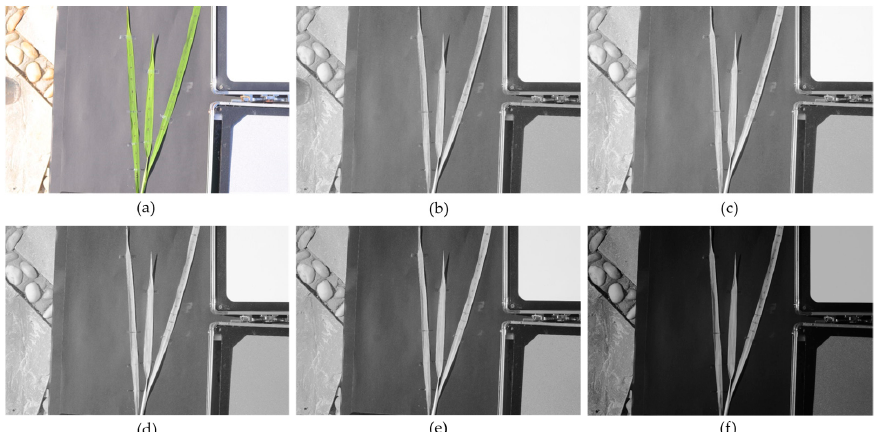
Figure 2. Image Set I: rice plant images with white panels in the top right corner and gray reflectance panels in the bottom right corner, which were captured on the ground, indicate the following: ( a ) red, green, and blue (RGB) visible image; ( b ) 650 nm near-infrared (NIR) image; ( c ) 680 nm NIR image; ( d ) 720 nm NIR image; ( e ) 760 nm NIR image; and ( f ) 850 nm NIR image.